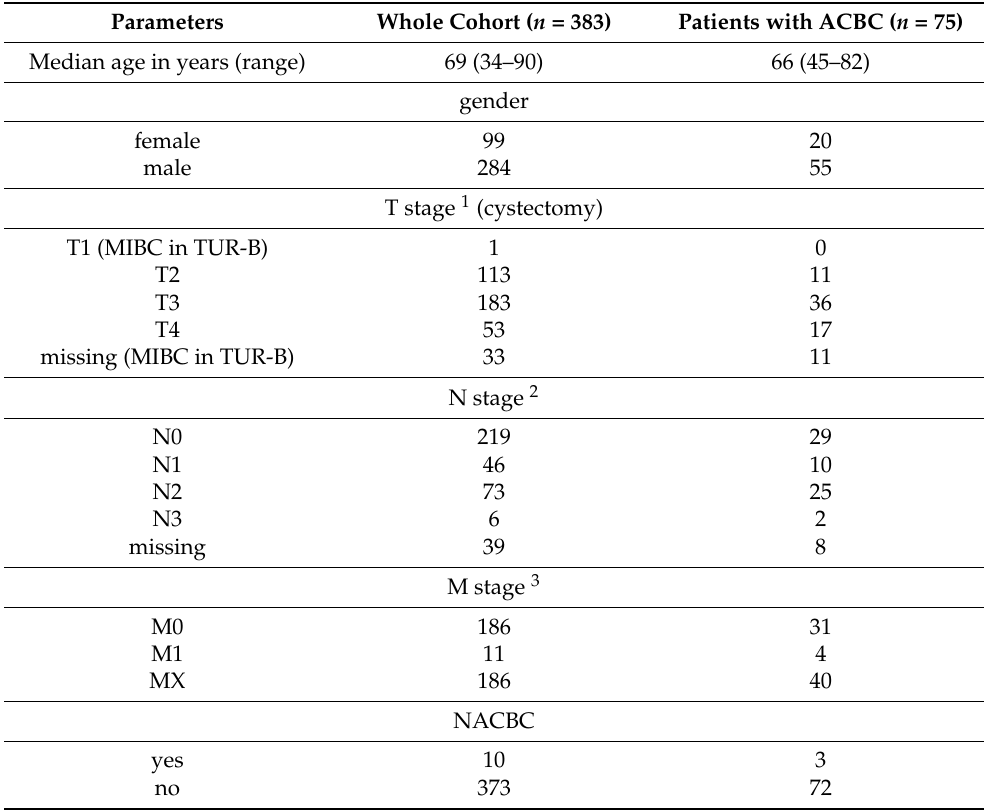
Table 2. Patient characteristics of the The Cancer Genome Atlas (TCGA) cohort.